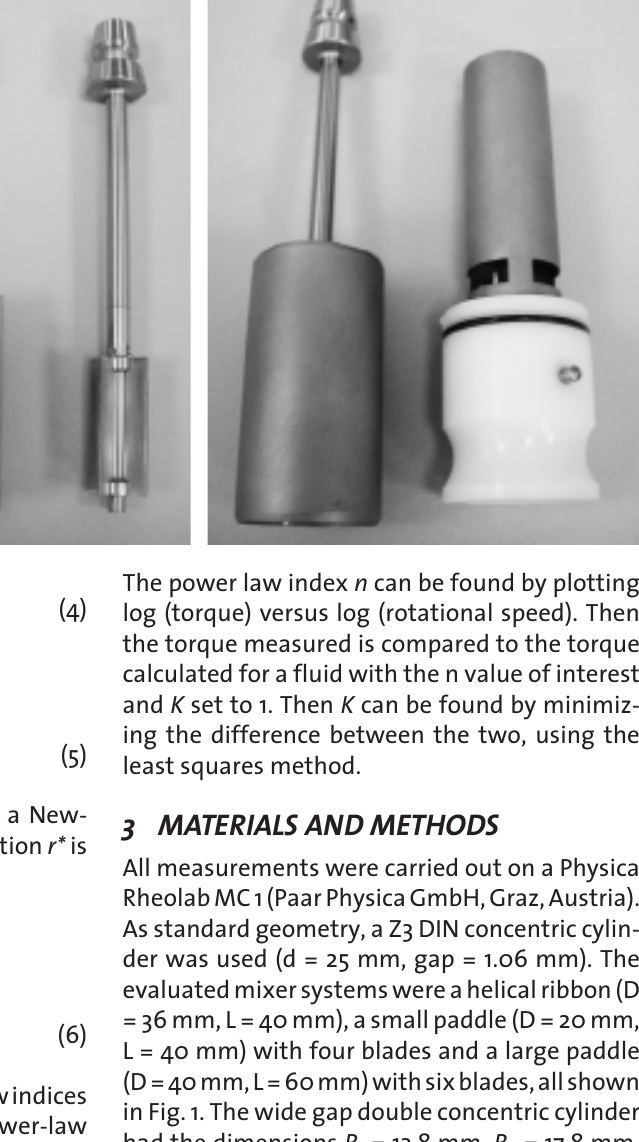
Figure 1: Helical ribbon (a – left) and large and small paddle (b –middle). Figure 2 (right): Wide gap double concentric